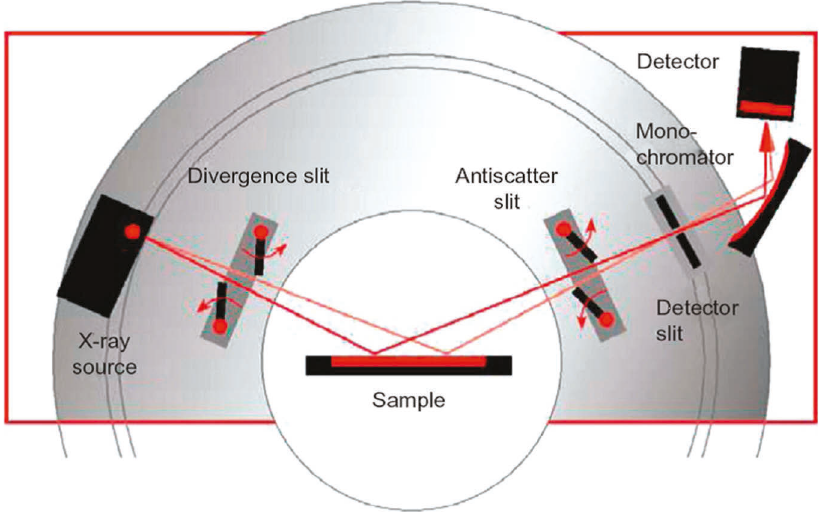
Figure 4: The Bragg–Brentano geometry used in modern diffractometers